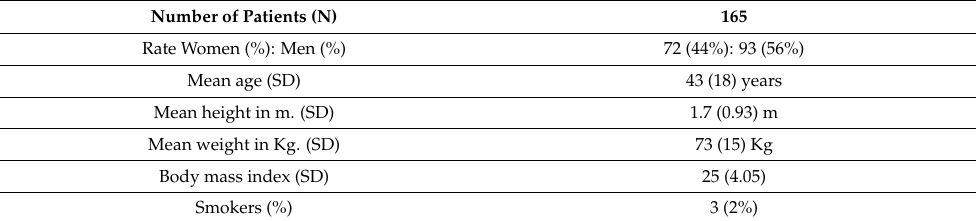
Table 2. Types of Surgeries and Use of Allografts. Mean Duration of the Surgery (SD) 70 (31) min. Rate of open (%): arthroscopic (%): combined (%) procedures Use of